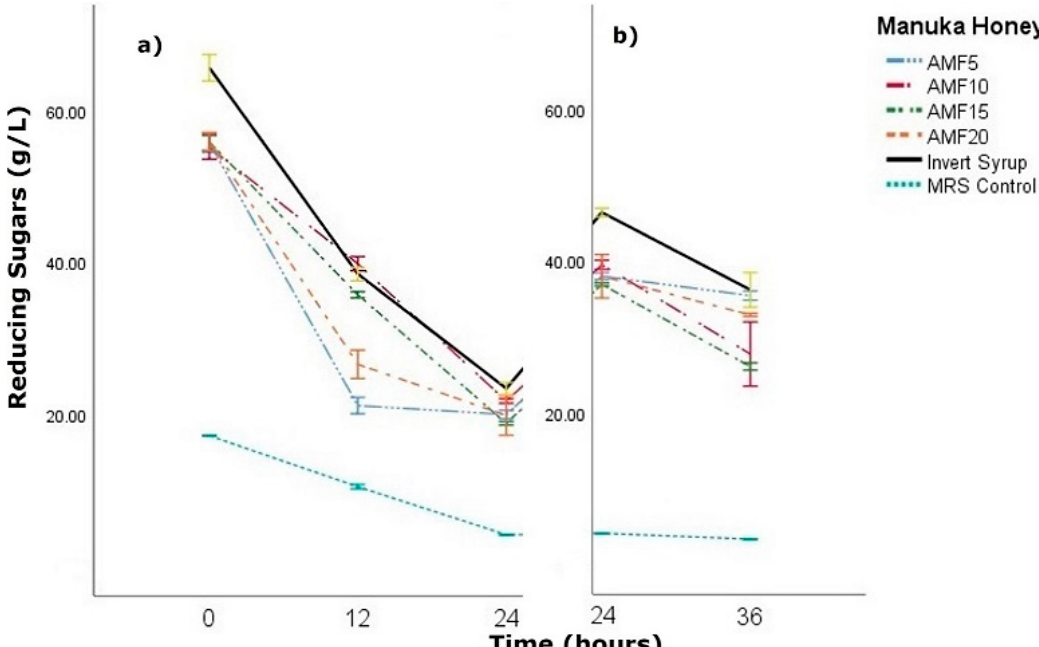
Figure 2. Reducing sugars concentration (g/L) in fermented MRS broth with Manuka honey (AMF TM 5 + , 10 + , 15 + and 20 + ), invert syrup and unsweetened control during the fermentation period ( a ) up to 24 h and ( b ) 24–36 h. Error bars represent the standard error of mean (SEM).